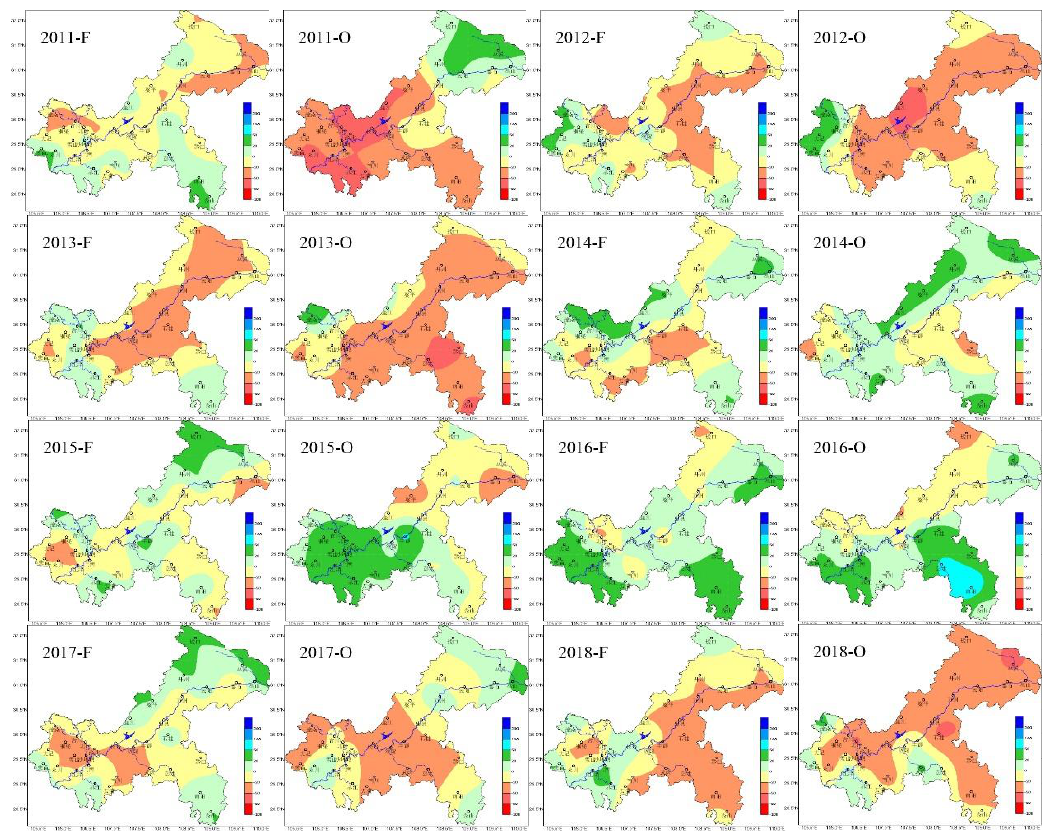
Figure 4. Forecast and observation distribution of summer precipitation in Chongqing based on random forest. (F) and (O) mean forecasting and observation, respectively Table 5. Comparison Table of random forest summer precipitation and release forecast from 2011 to 2018.